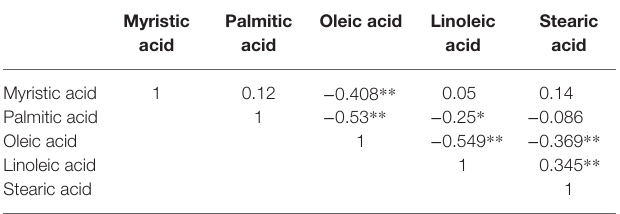
TABLE 3 | Association between different fatty acid